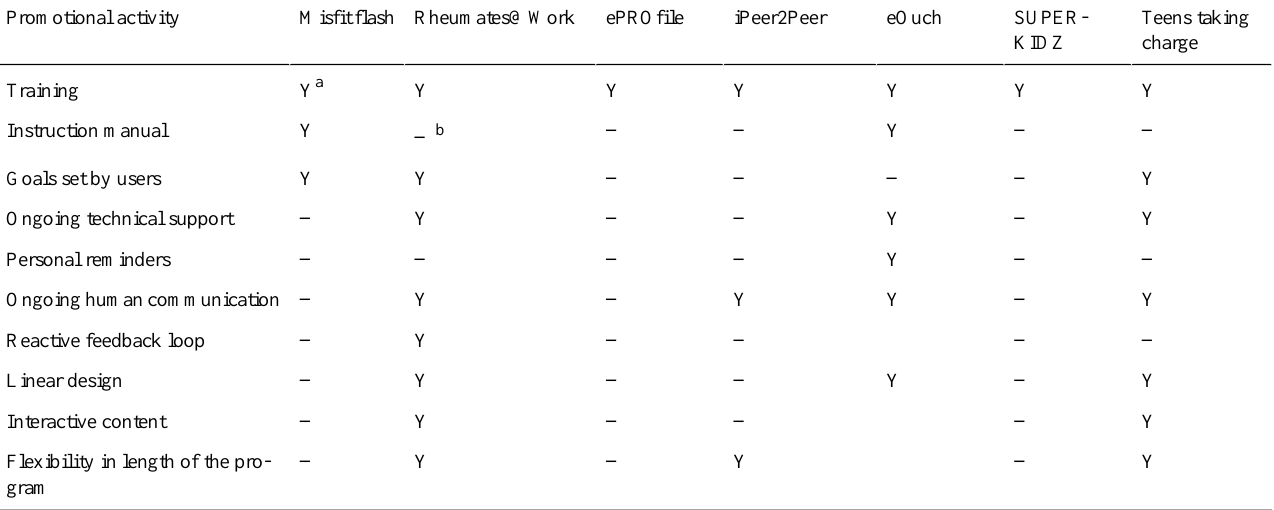
Table 3. Promotional activities used to support engagement with the intervention for juvenile idiopathic